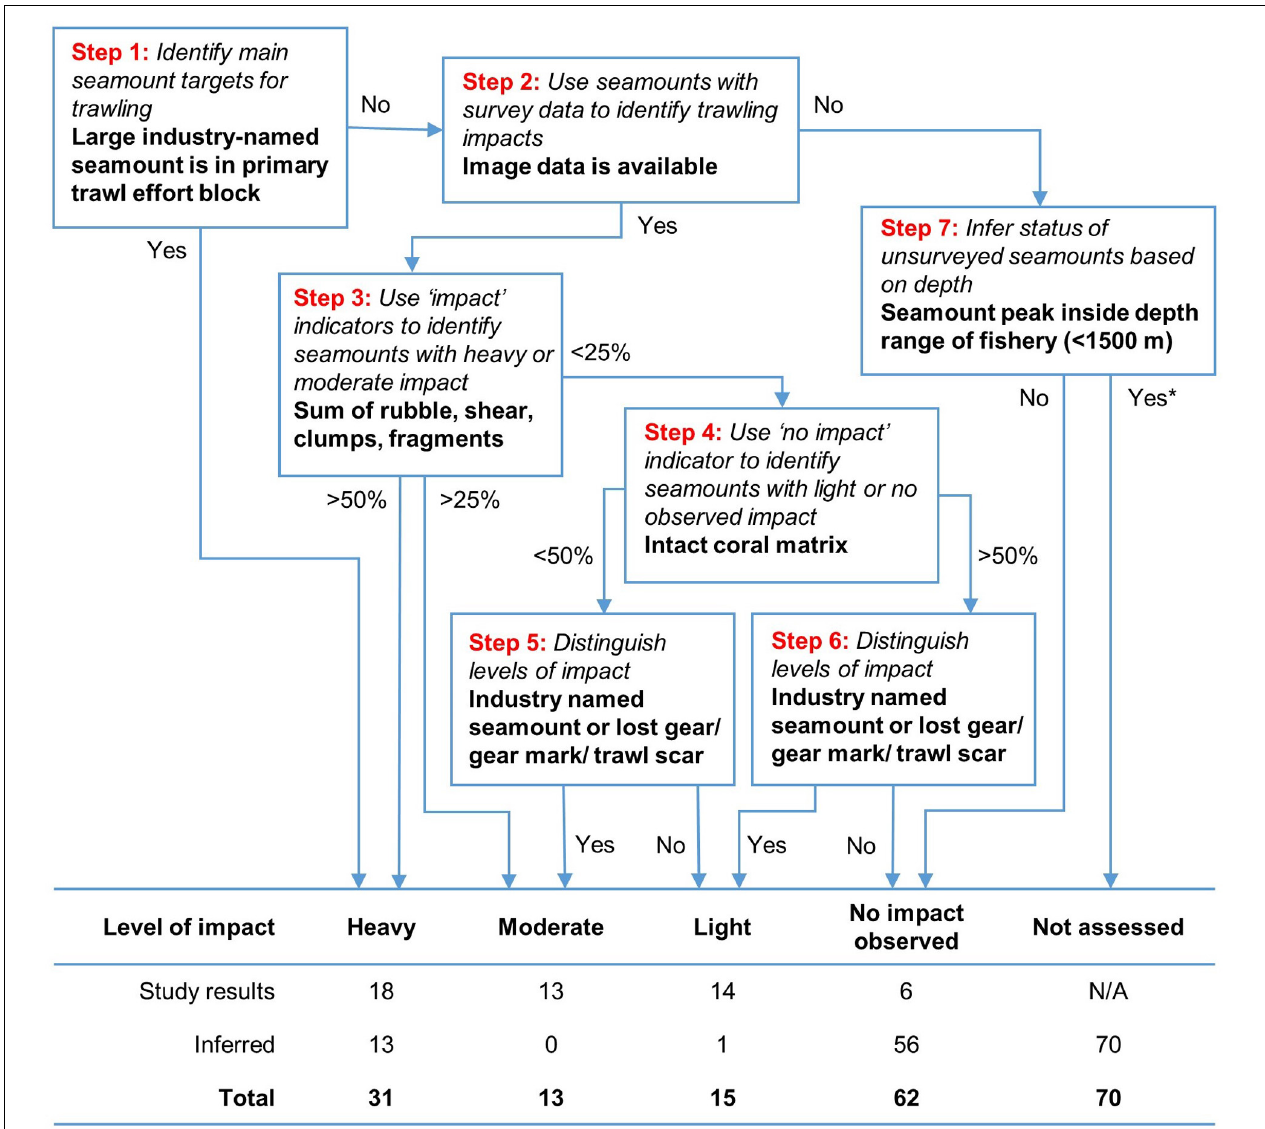
FIGURE 9 | A step-wise hierarchical classification process to classify relative levels of impact on individual seamounts. The steps use a seamount’s membership of blocks with high trawl effort, arbitrary thresholds of 25 and 50% to split the proportional indicators of “impact” and then indicator of “no impact,” and presence of lost gear/gear marks/trawl scars and/or industry-named seamounts. Impact on unsurveyed seamounts inferred from their membership of trawl effort blocks and whether or not they peak inside the operating depth of the